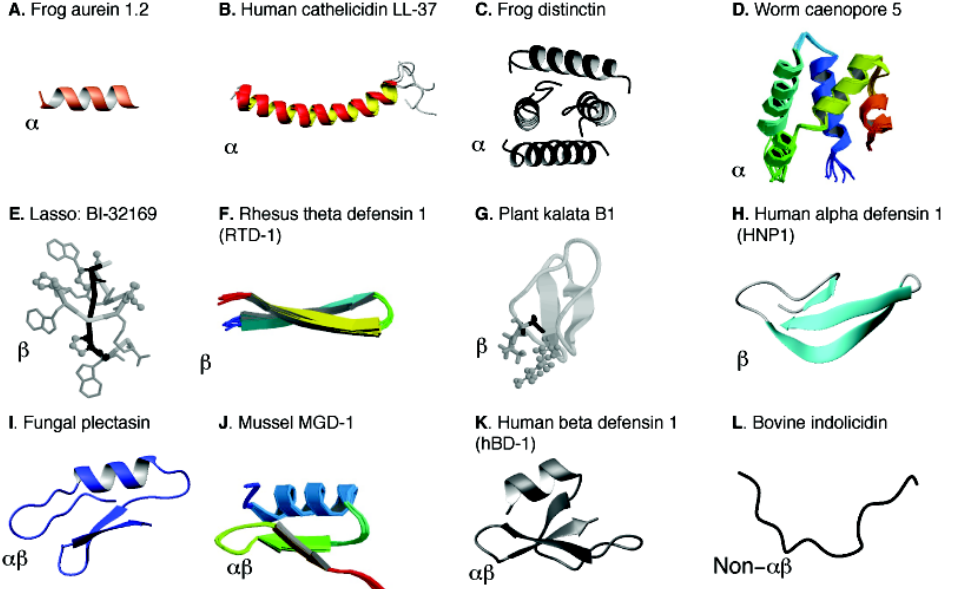
Figure 4. Structural diversity and classification of natural antimicrobial peptides. The known structures of AMPs are classified into four families (  ,  ,  , and non-  ) [26] and the structural family for each peptide is indicated at the left bottom corner of each panel. The PDB IDs and references for these structures are: ( A ) 1VM5 [50] for aurein 1.2 in complex with SDS micelles; ( B ) 2K6O for human cathelcidin LL-37 in complex with SDS micelles [71]; ( C ) 1XKM for amphibian distinctin in water [114]; ( D ) 2JS9 for caenopore-5 [115] from Caenorhabditis elegans ; ( E ) 3NJW for BI-32169 as a representative lasso structure [116]; ( F ) 2LYF for  -defensin RTD-1 [117,118]; ( G ) 1KAL for plant kalata B1 [119]; ( H ) 3GNY for human α -defensin 1 (or human neutrophil peptide-1; HNP-1) [120]; ( I ) 1ZFU for fungal plectasin [80]; ( J ) 1FJN for mussel MGD-1 [121]; ( K ) 1E4S for human beta defensin 1 (HBD-1) [122]; and ( L ) 1G89 for bovine indolicidin [123]. Structural coordinates were obtained from the RCSB Protein Data Bank (PDB)